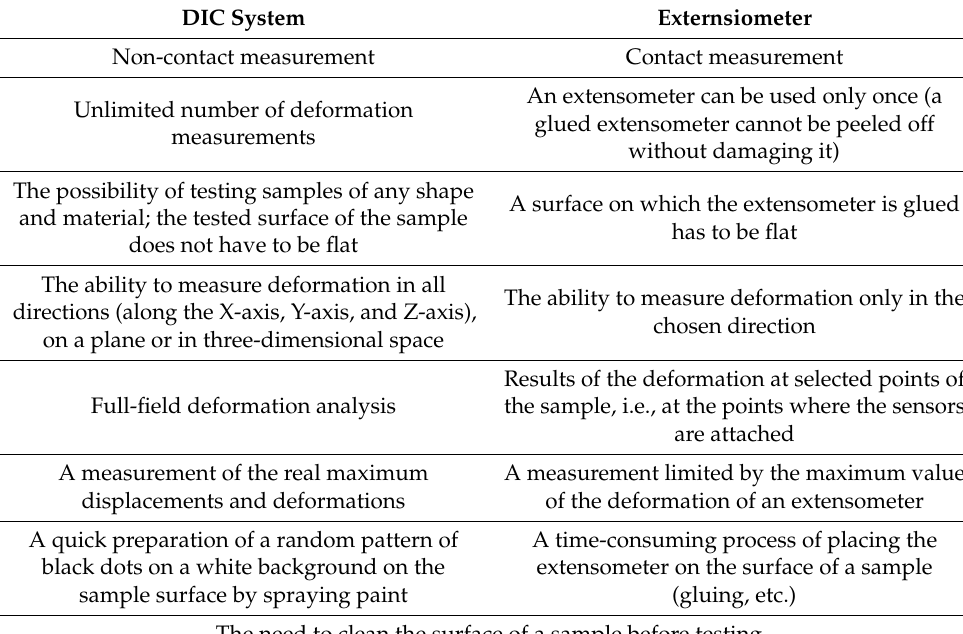
Table 2. Comparison between DIC system and